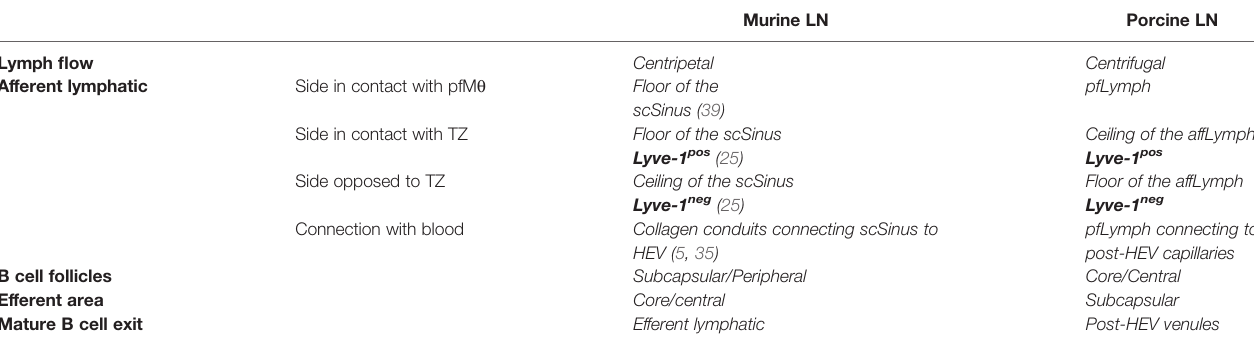
TABLE 2 | Comparison of the main murine and porcine LN